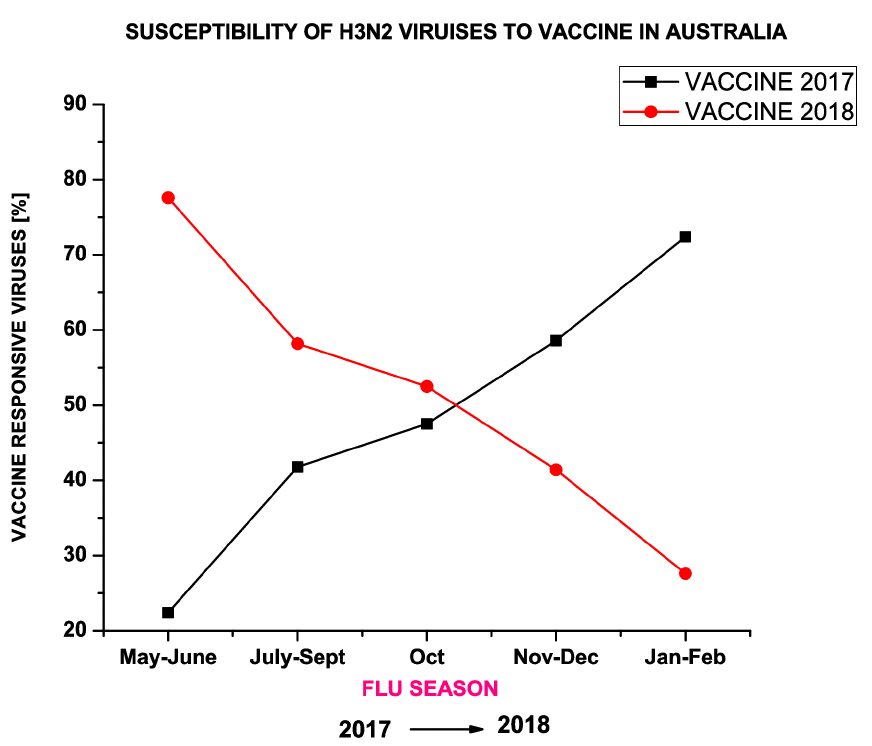
Figure 2. Assessment of the responsiveness to flu vaccines A/Hong Kong/4801/2014 and A/Singapore/INFIMH-16-0019/2016 of H3N2 viruses collected in Australia between May 2017 and February 2018 .